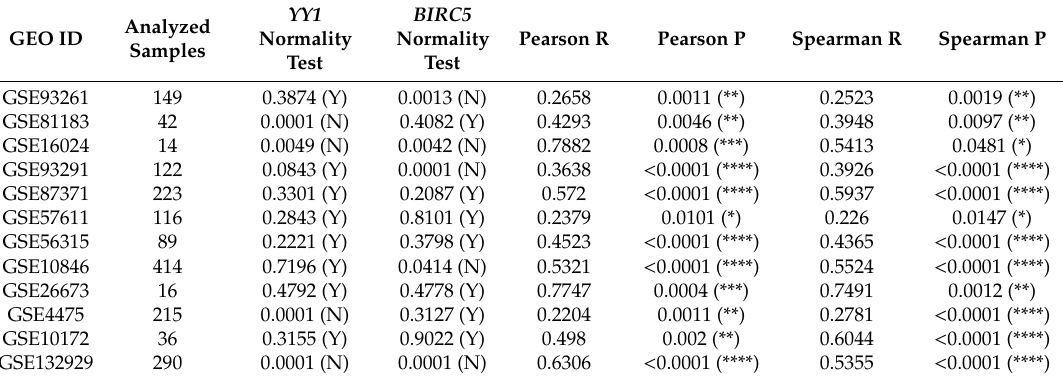
Table 3. YY1 and BIRC5 Normality test, Pearson and Spearman correlation (R-Value)